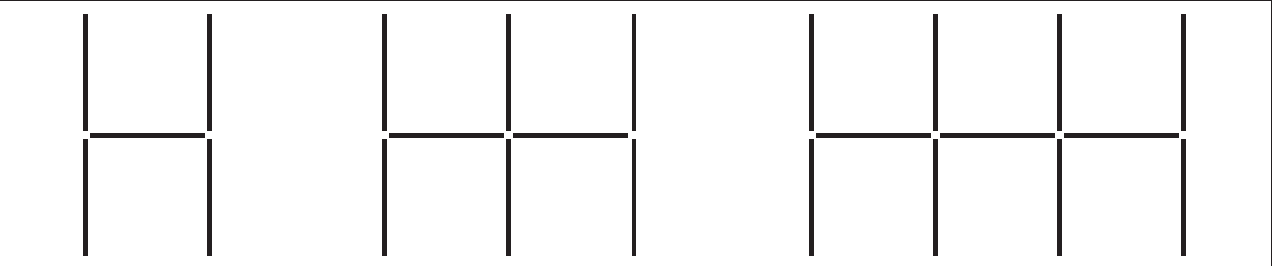
FIGURE 2: A simple pictorial sequence.